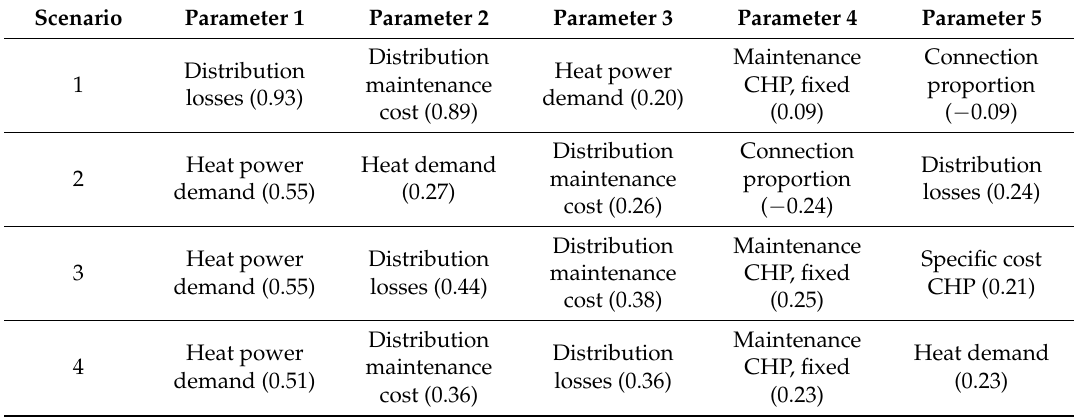
Table A1. The five parameters with the highest absolute correlation coefficient for each scenario, with the value of the correlation coefficient in